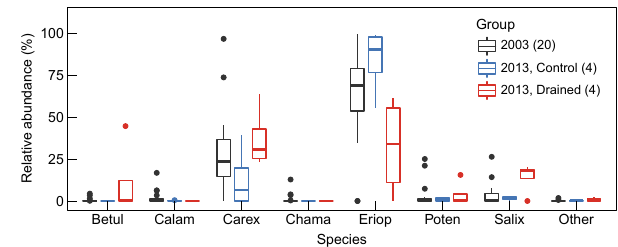
Figure 7. Abundances of vegetation species observed across the transects in 2003 and 2013. Numbers in parentheses are the number of replicates. Boxplot contains median, 25 and 75% quartiles, and ± 1.5 interquartile ranges. Betul: Betula ex- ilis , Calam: Calamagrostis purpurascens , Carex: Carex species, Chama: Chamaedaphne calyculata , Eriop: Eriophorum angusti- folium , Poten: Potentilla palustris , Salix: Salix